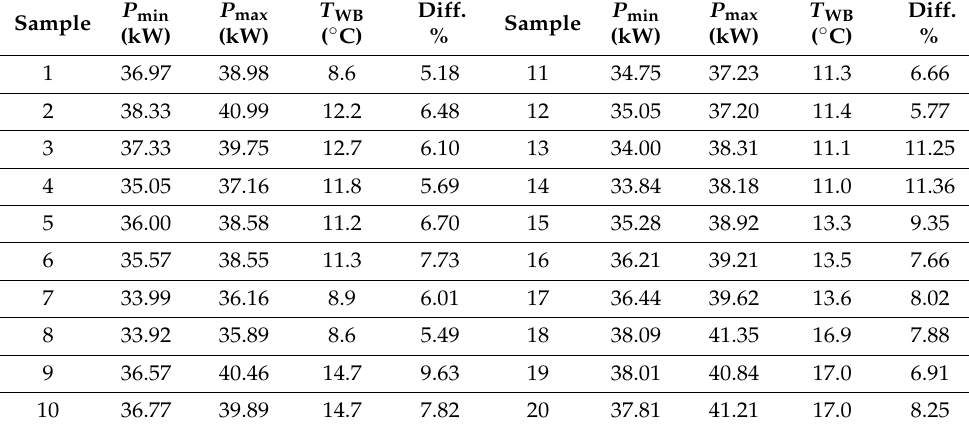
Table 3. Overall compressor and condenser electrical power demands.